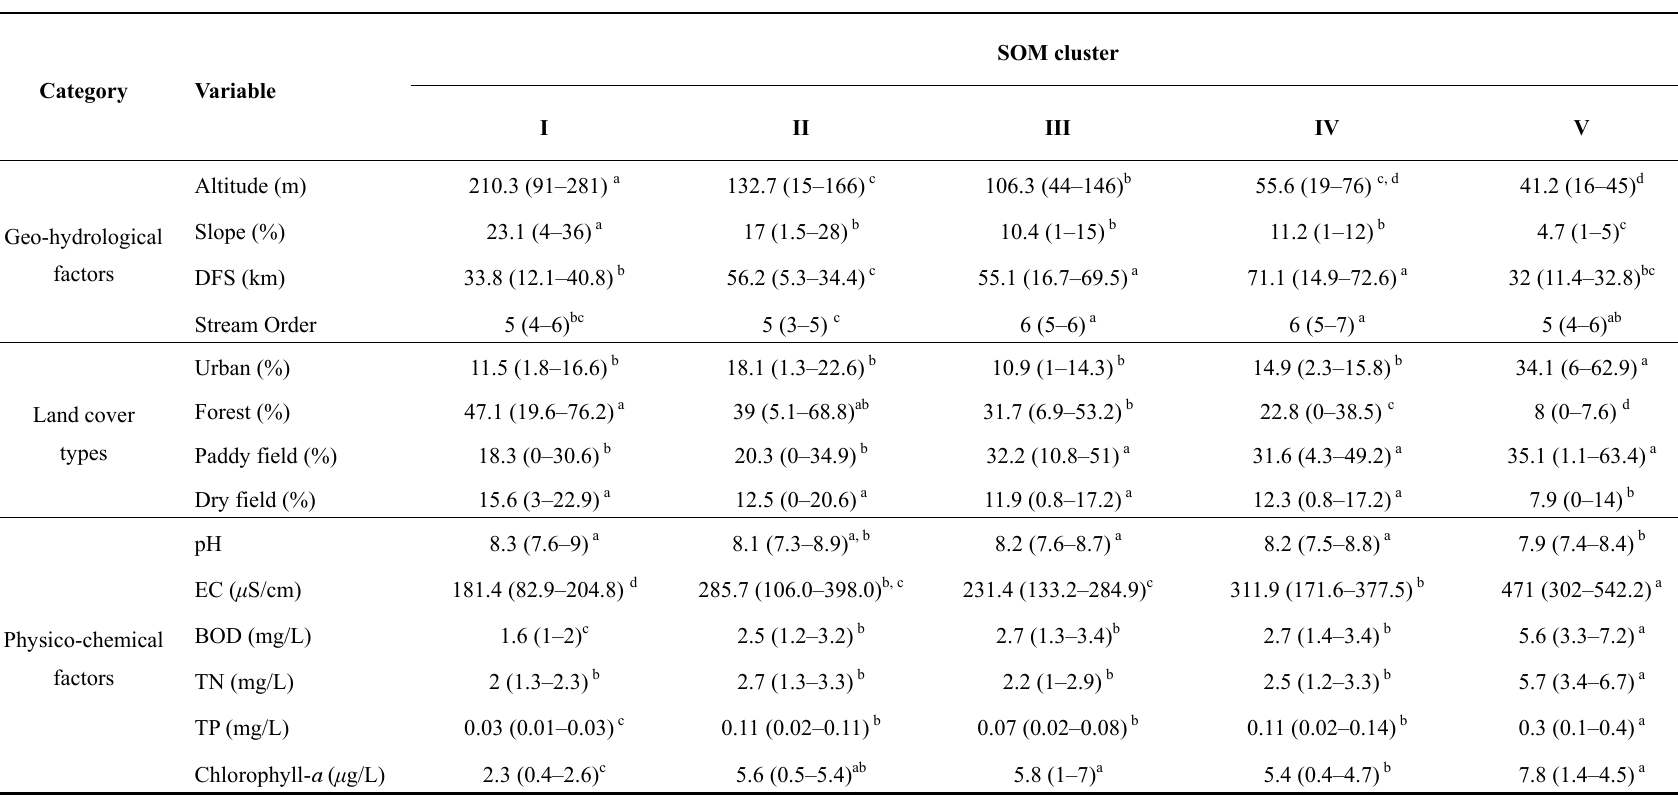
Table 4. Differences in environmental variables among the five clusters defined by the SOM. The number indicates mean (1st quartile–3rd quartile) in each clusters. Different letters in each row indicate significant differences for that variable among the clusters based on Dunn’s multiple comparison tests ( P <